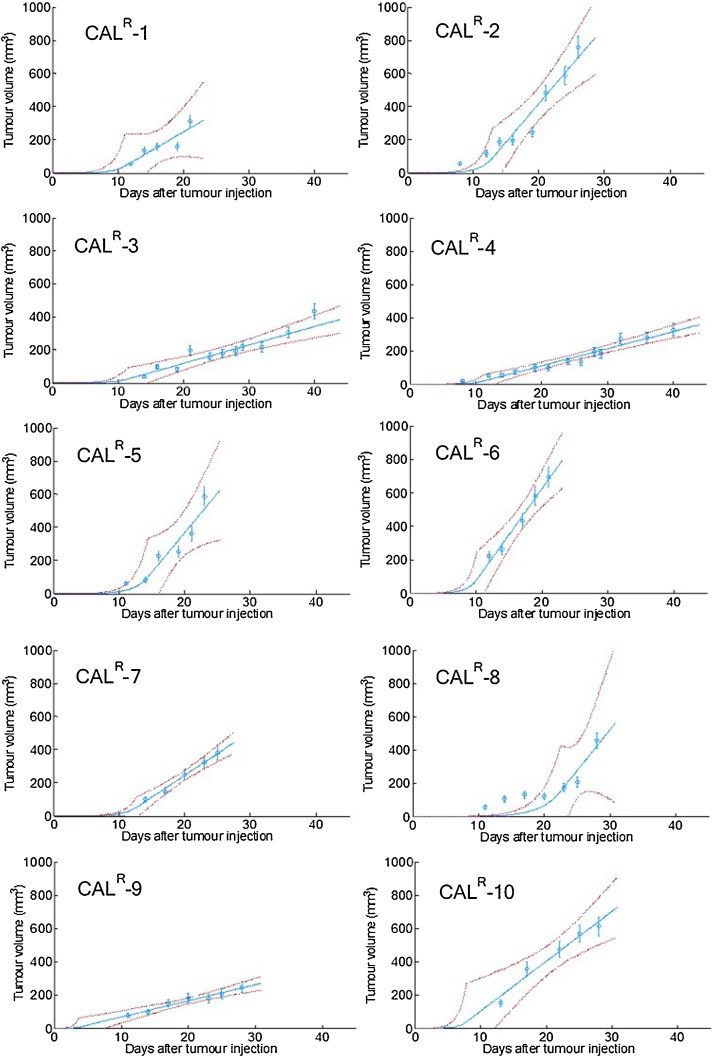
CALR tumour volume, as measured by calipers (blue circles). Error bars represent tumour volume error, as described by Eq. 2. The exponential-linear fitted model is shown by the blue full line with 95% confidence intervals (dashed red lines).